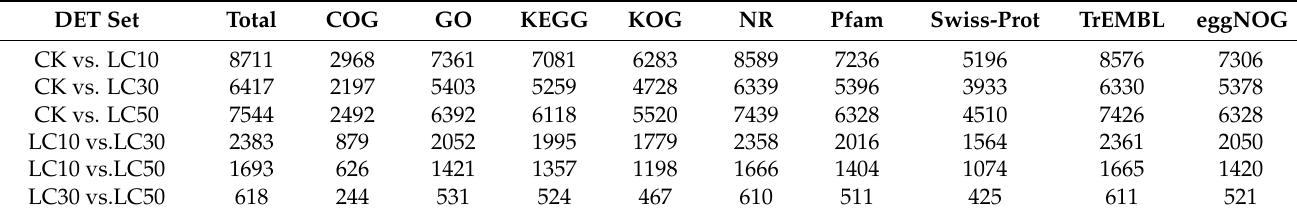
Table 3. Annotated DETs number statistics